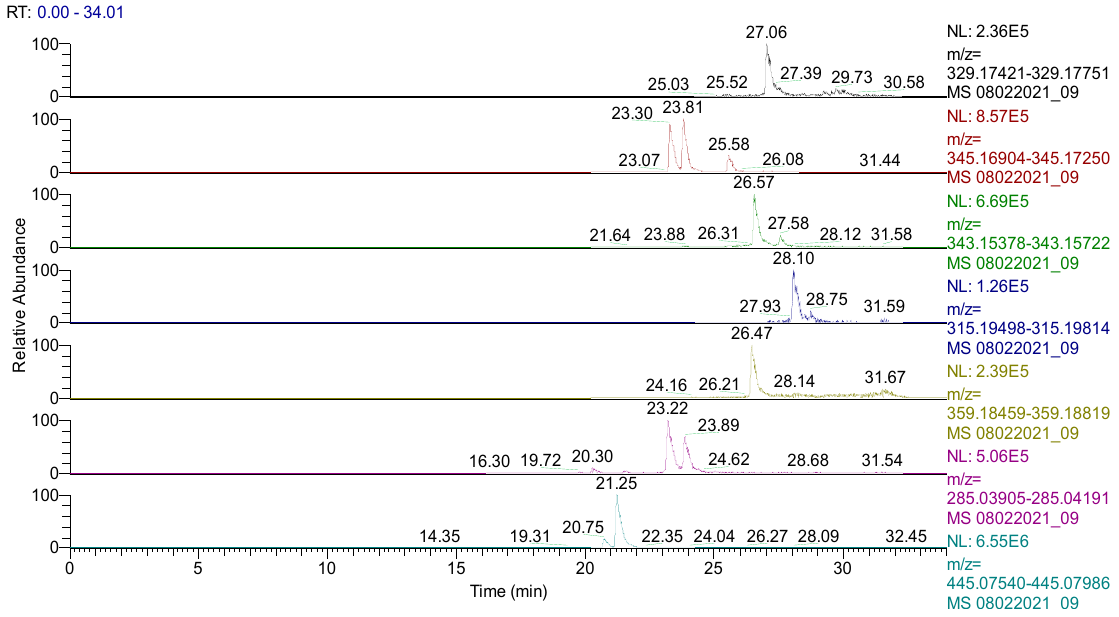
Figure 6. Diagram for CHE compounds representative of the profile of polyphenolic derivatives obtained by the hierarchical grouping methods Ward and HCA (Hierarchical Cluster Analysis; another illustration of the dendrogram for CHE-flavonoids, phenolic acids, dicarboxylic acids, and other representative compounds).